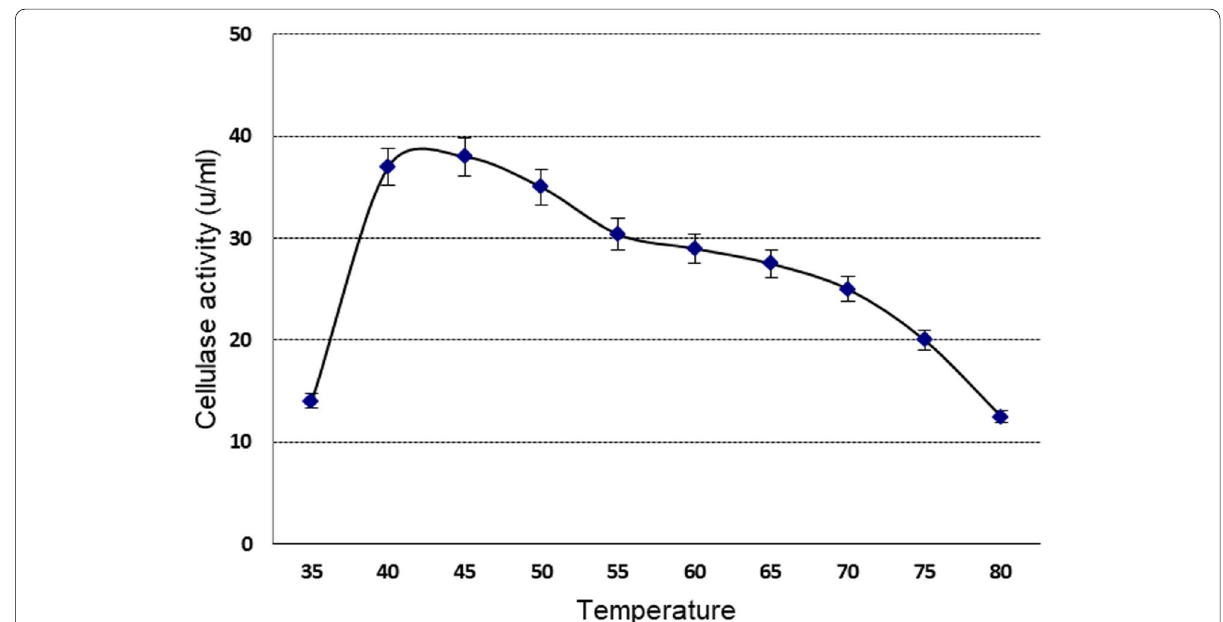
Fig. 6 Optimum temperature of the recombinant cellSNSY enzyme